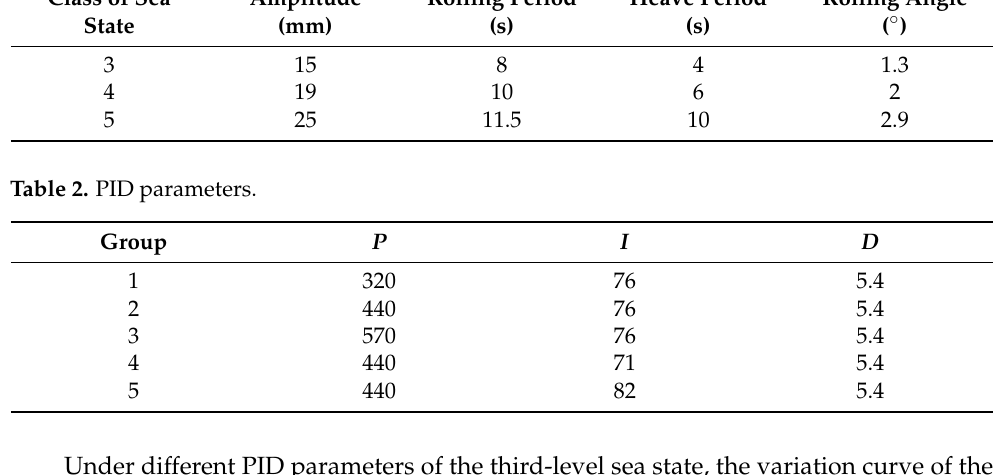
Table 1. Simulation parameters of a six-degrees-of-freedom moving platform under different sea conditions.